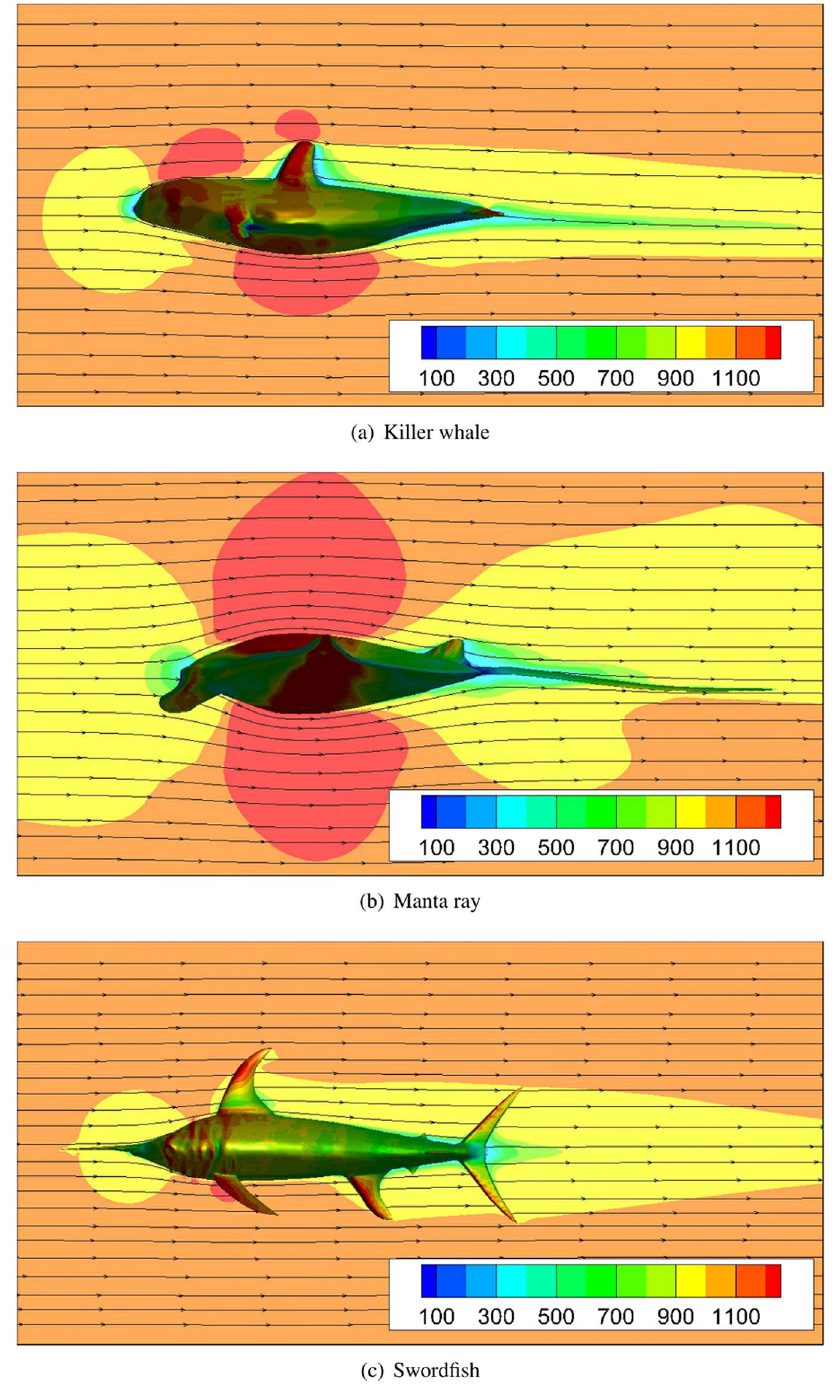
Figure 4. Dynamic pressure contour plots with streamlines at U = 4 m/s for Case UW. The CAD models are created in Rhinoceros 17